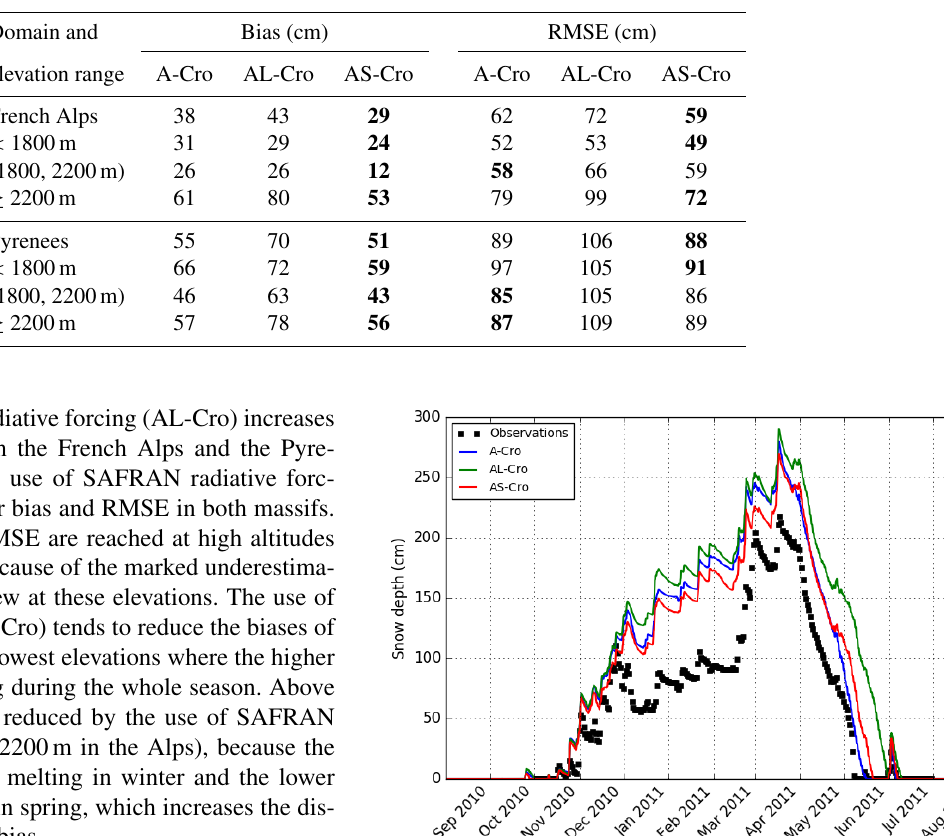
altitude (point B, 2459 m), both located in Fig. 9.